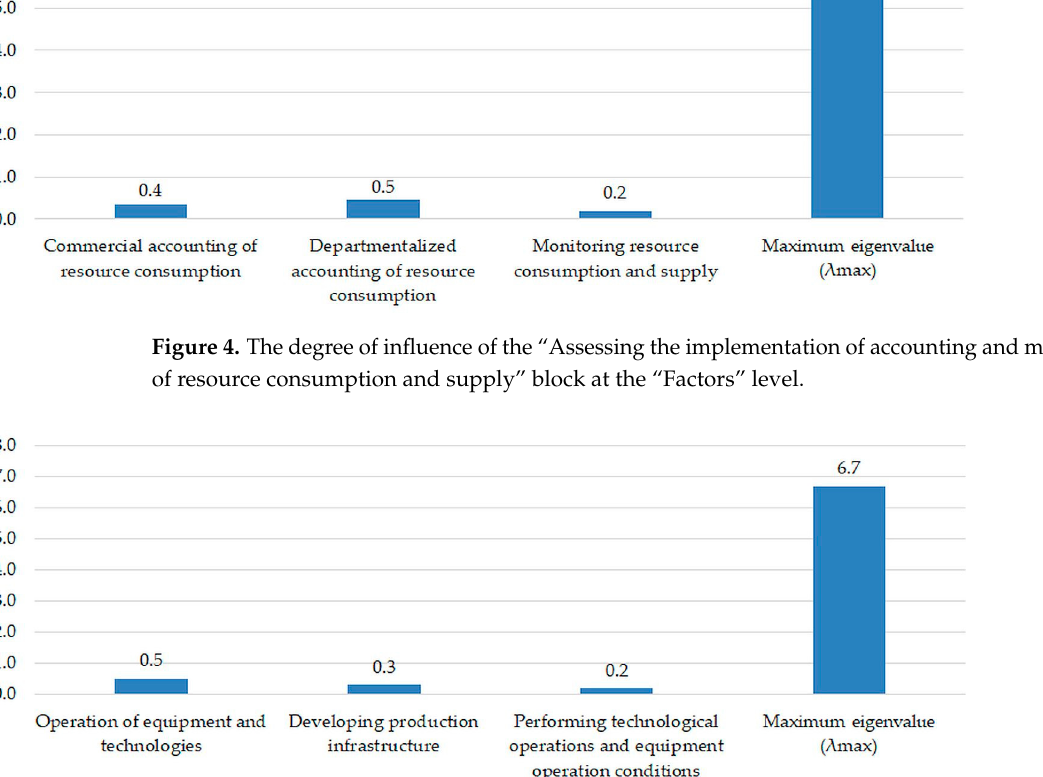
Figure 6. Degree of influence of the “Improving the organization of work to improve resource effi- ciency and resource conservation” block at the “Factors” level.